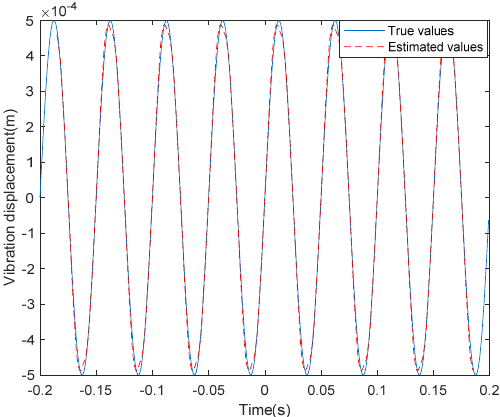
Figure 5. Real and estimated values of high-frequency vibration displacement.